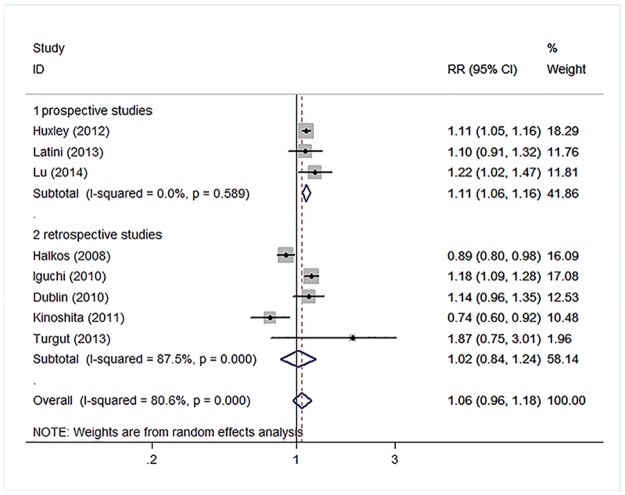
Forest plot demonstrating the association between HbA1c levels and AF depending on different study styles which HbA1c levels were analyzed as continuous variable.Relative risks of AF for higher HbA1c compared with lower HbA1c. Squares indicate study-specific risk estimates (size of the square reflects the study-specific statistical weight, that is, the inverse of the variance); horizontal lines indicate 95% CIs; diamond indicates summary risk estimate with its corresponding 95% CI.